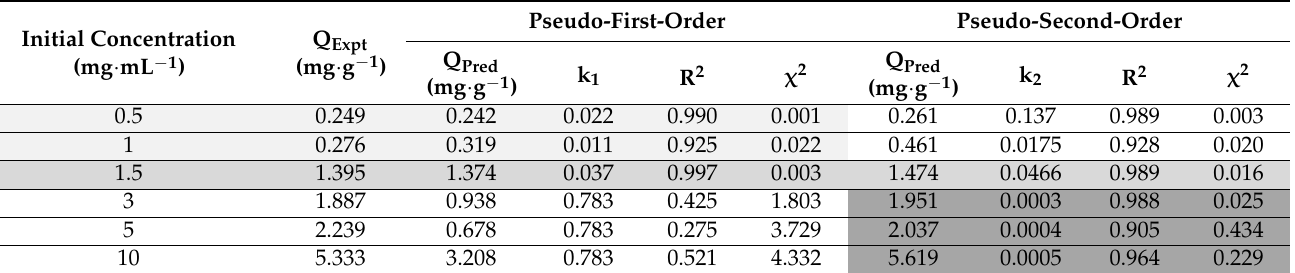
Figure 1. Fitting of qt (mg BSA/g of monolith) data as a function of time with pseudo-1st-order and pseudo-2nd-order kinetic models, using initial BSA concentrations: ( a ) 0.5 mg · mL − 1 BSA, ( b ) 1.5 Table 1. Experimentally determined and theoretically predicted parameters for adsorption kinetics models.